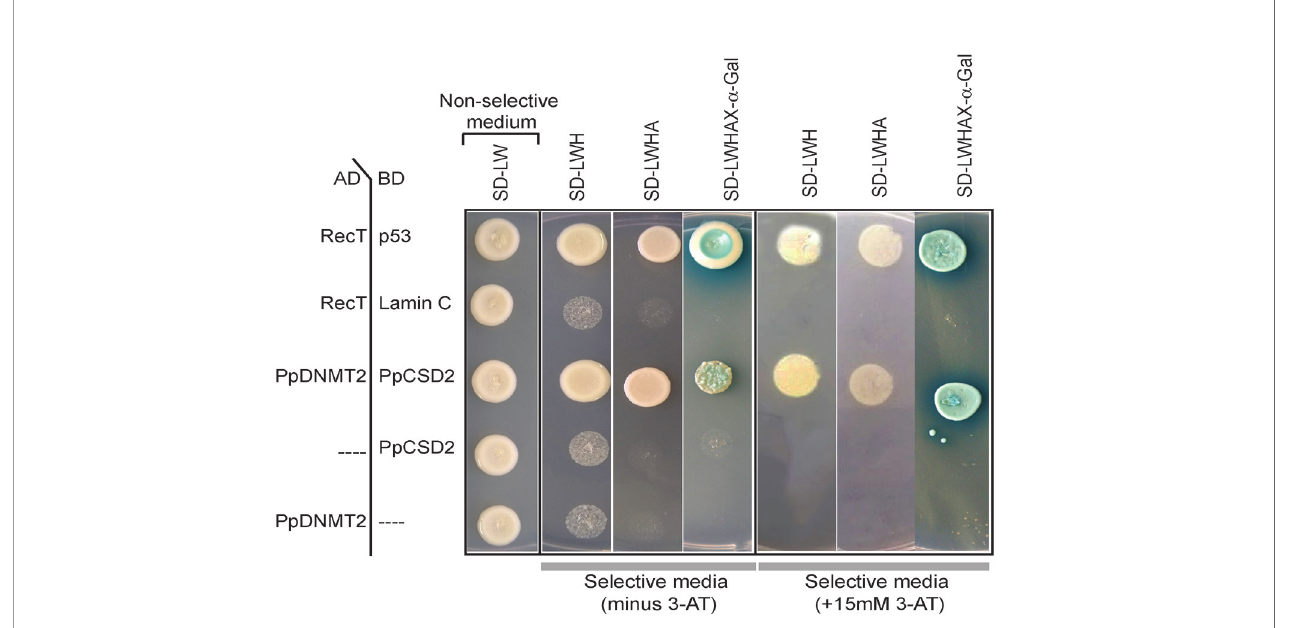
FIGURE 9 | Yeast two-hybrid assay showing direct interaction between PpDNMT2 and PpCSD2. PpDNMT2 and the SV40 large T antigen (RecT) are expressed as GAL4-AD fusion protein while p53, human Lamin C, and the bait protein (PpCSD2) are expressed as GAL4 DNA binding domain (BD) fusion proteins. Non-selective and Selective synthetic dropout media lacking leucine (L), Tryptophan (W), Histidine (H) and Adenine (A) are mentioned